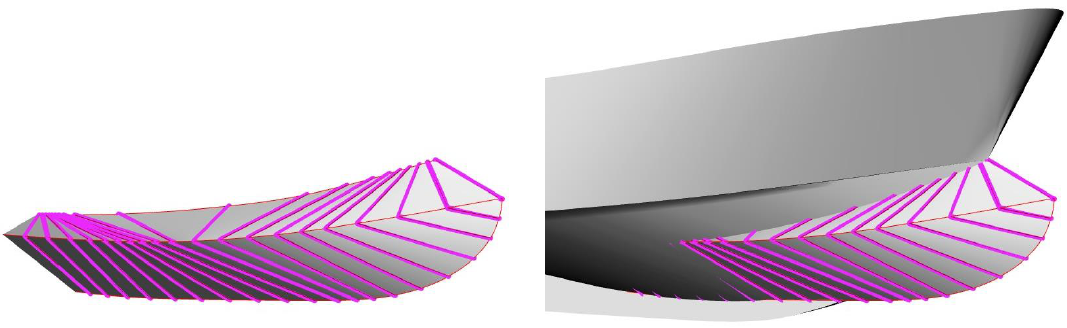
Figure 13. Rulings for the dihedral bow of example 1 (FAO4).